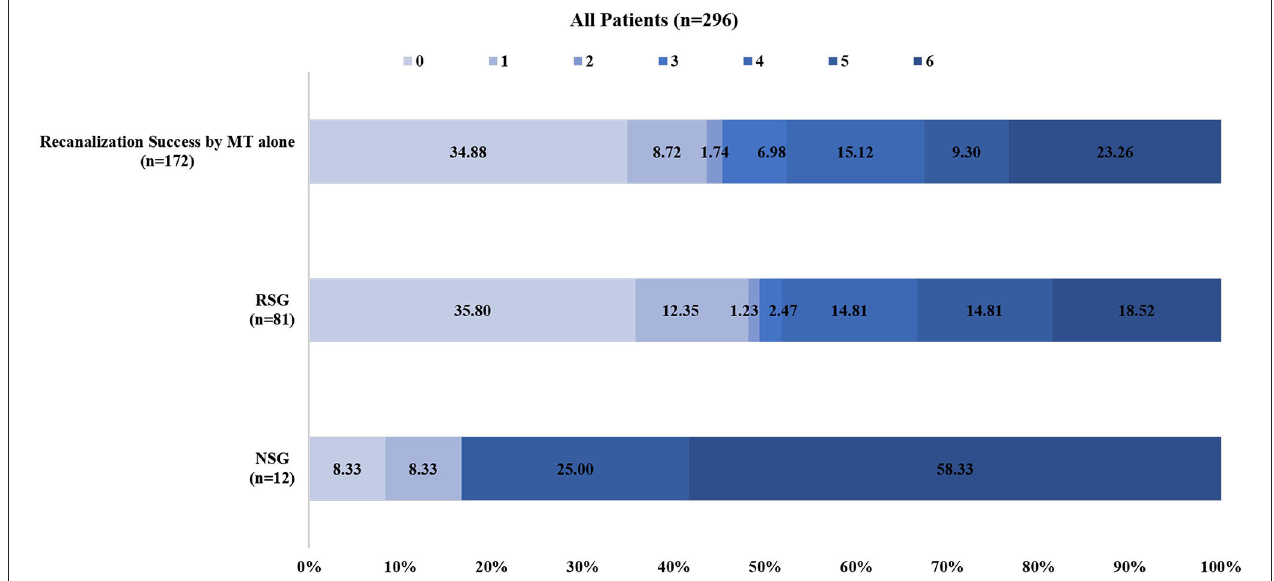
FIGURE 2 | Distributions of the 3-month modified Rankin Scale score (mRS) of patients with recanalization success by mechanical thrombectomy alone and patients with rescue stenting and without rescue stenting after mechanical. MT indicates mechanical thrombectomy; Recanalization success, modified Tissue Thrombolysis in Cerebral Ischemia, 2b − 3; RSG, rescue stenting group; NSG, no stenting group.